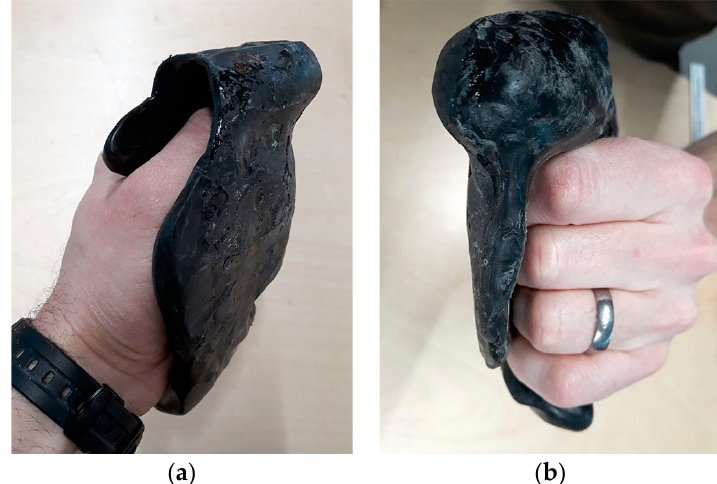
Figure 3. Existing wheelchair racing glove design made using Polymorph PCL thermoplastic (Mindsets): ( a ) a top view; ( b ) a front